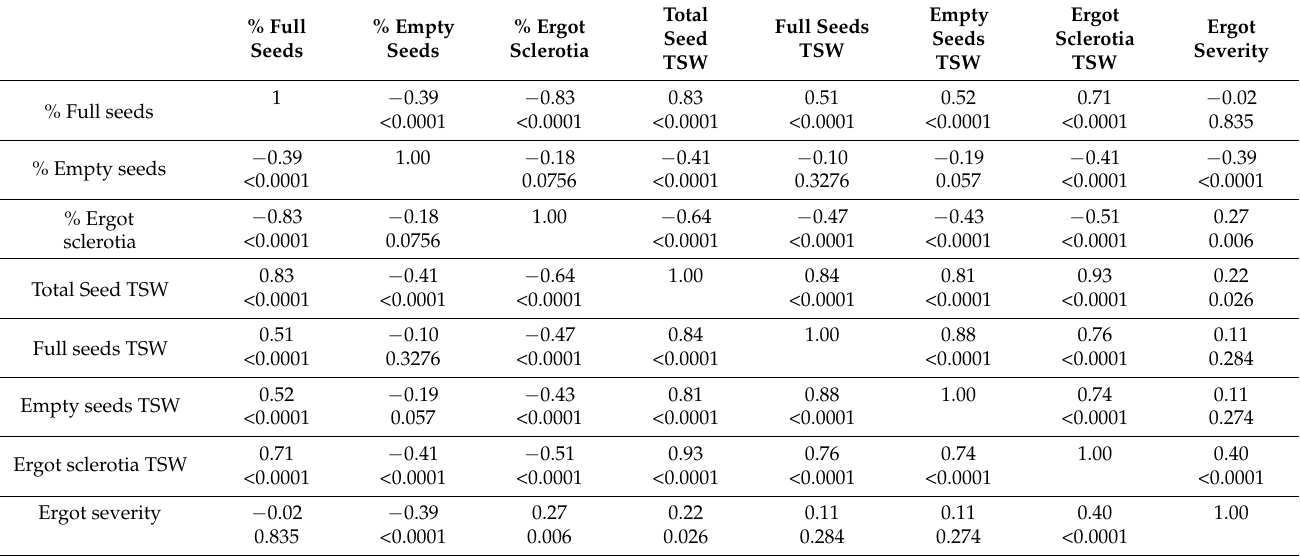
Table 5. Pearson correlation coefficients and probabilities between total seed fractions, kernels weight, and ergot severity of infection.